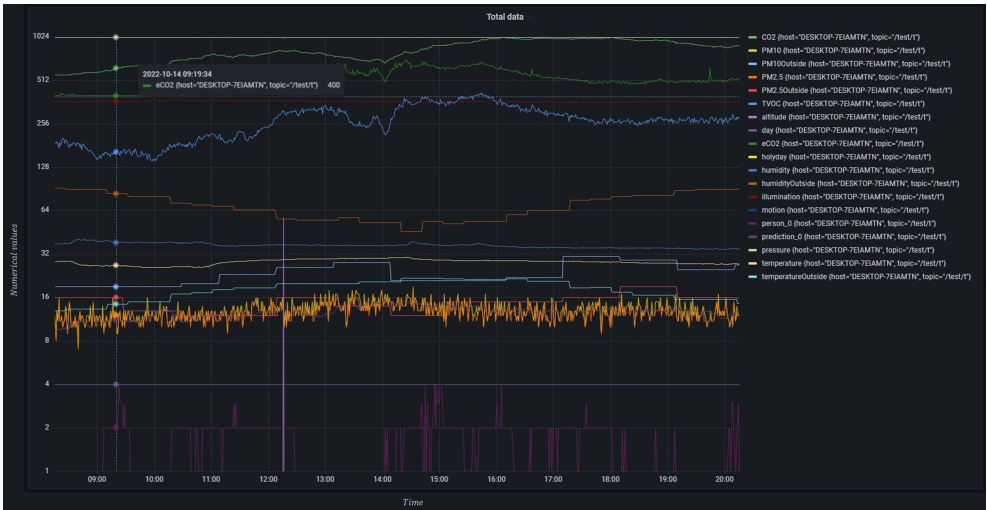
Figure 9. Total environmental data monitoring